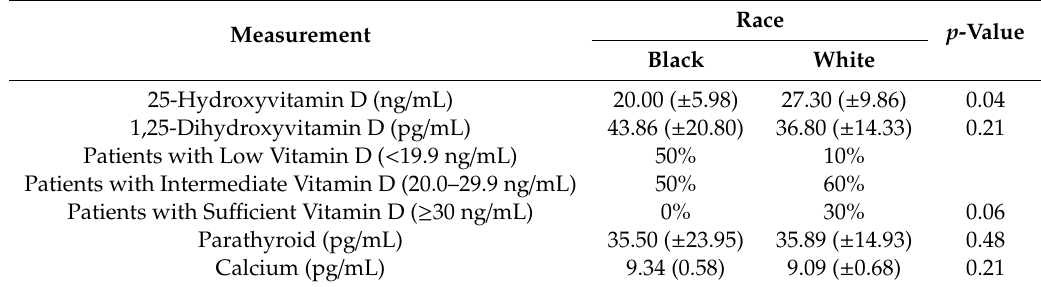
Table 2. Blood levels of vitamin D, parathyroid, and calcium among head and neck cancer patients.